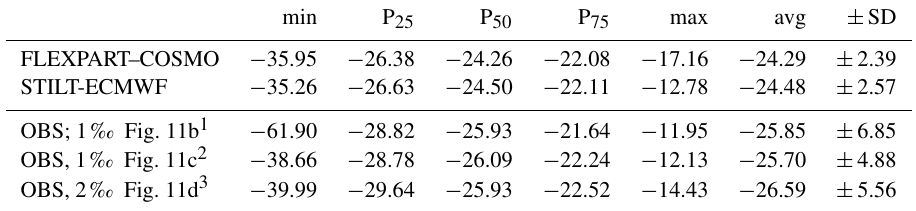
Table 6. Summary statistics of δ 13 C m (‰, 2012–2015).